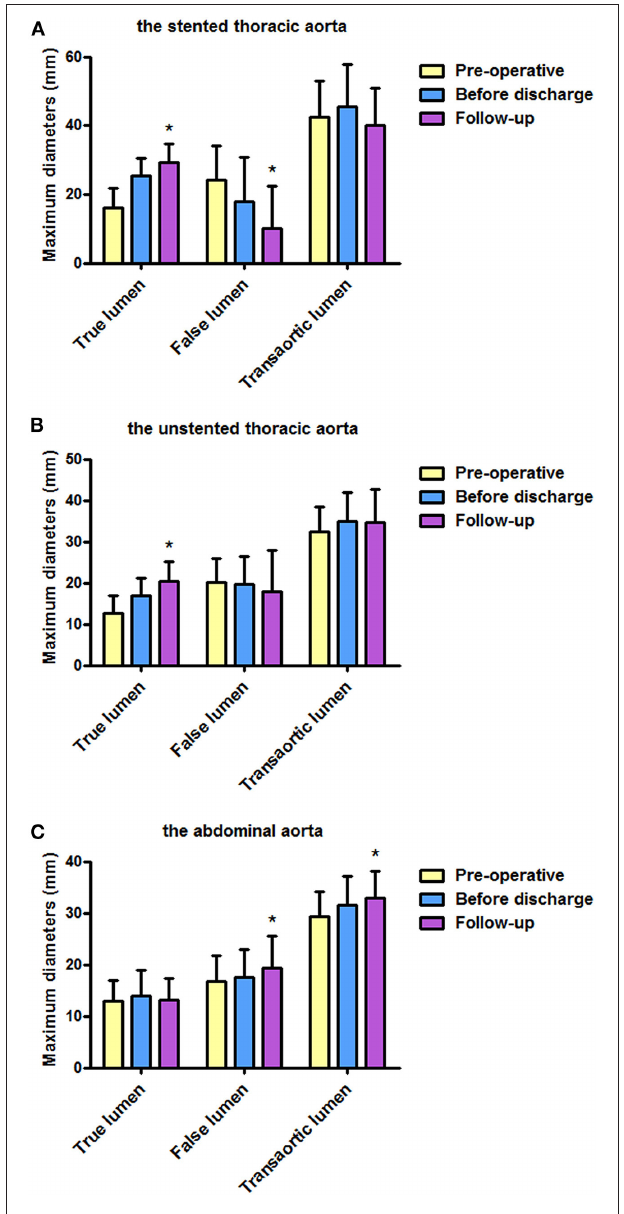
FIGURE 1 | Maximum diameters of FL, TL, and transaorta pre-operatively, before discharge, and during follow-up. (A) Average maximum diameters of the stented thoracic aorta were stable, average diameters of the stented thoracic TL increased, and average diameters of the stented thoracic FL decreased. (B) Average diameters of the unstented thoracic TL increased. (C) An increase in average maximum diameters observed in the abdominal aorta was mainly attributed to FL enlargement. FL, false lumen; TL, true lumen. * P < 0.05 versus pre-operative or before